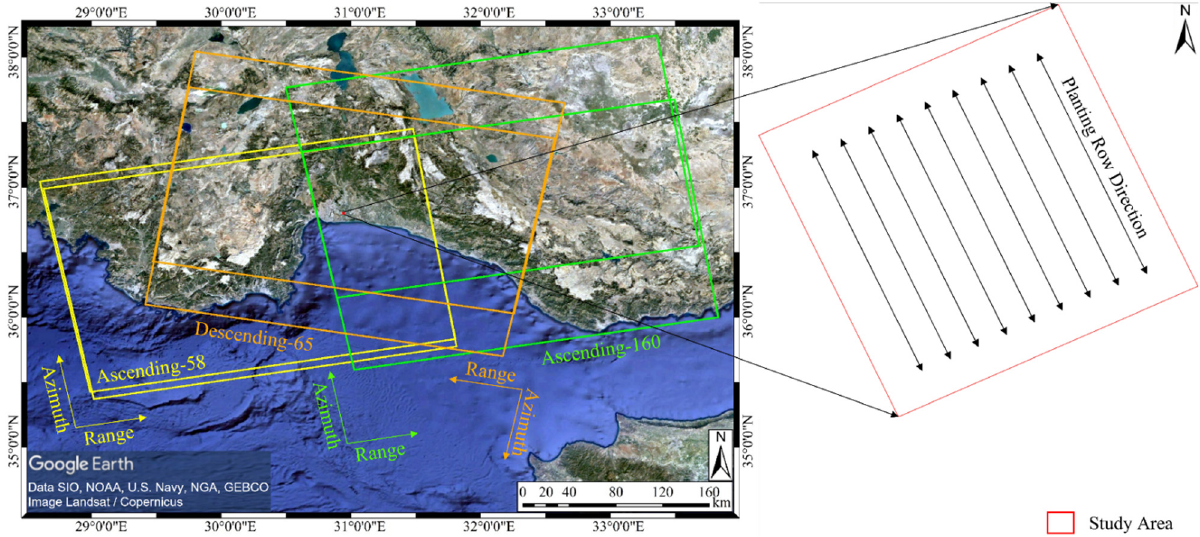
Figure 2. The footprints (coverage areas) of Sentinel-1 satellite images acquired from three different orbits used in the study (overlaid on Google Earth image) and the planting row direction of maize in the study area. Satellite images acquired from ascending orbit pass and relative orbit number 58 were called Ascending-58, satellite images acquired from ascending orbit pass and relative orbit number 160 were called Ascending-160, and satellite images acquired from descending orbit pass and relative orbit number 65 were called Descending-65.